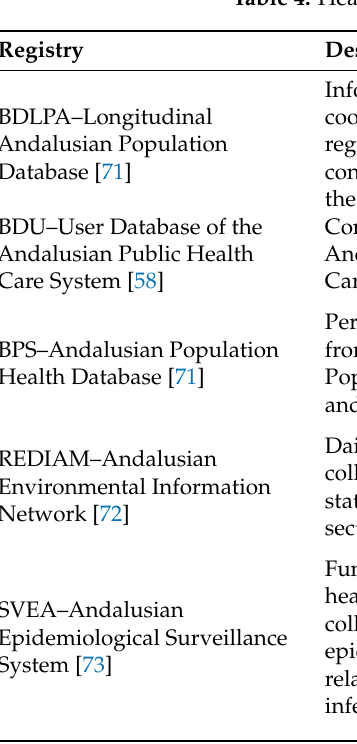
Table 4. Health Care and Social Survey (ESSOC): Auxiliary sources and